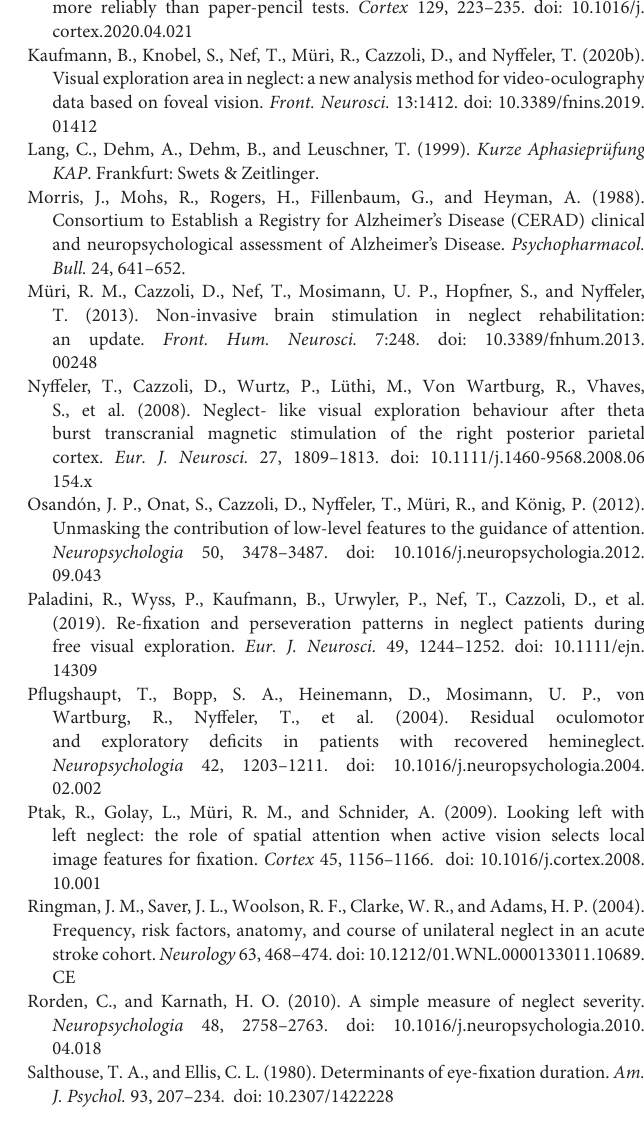
Supplementary Figure 1 | The histogram shows the spatial distribution of fixations during FVE over horizontal bins of 2 ◦ visual angle. The mean number of fixations per bin shows a left-ward shift in exploration behaviour for the left-hemispheric stroke patients (blue) compared to healthy controls